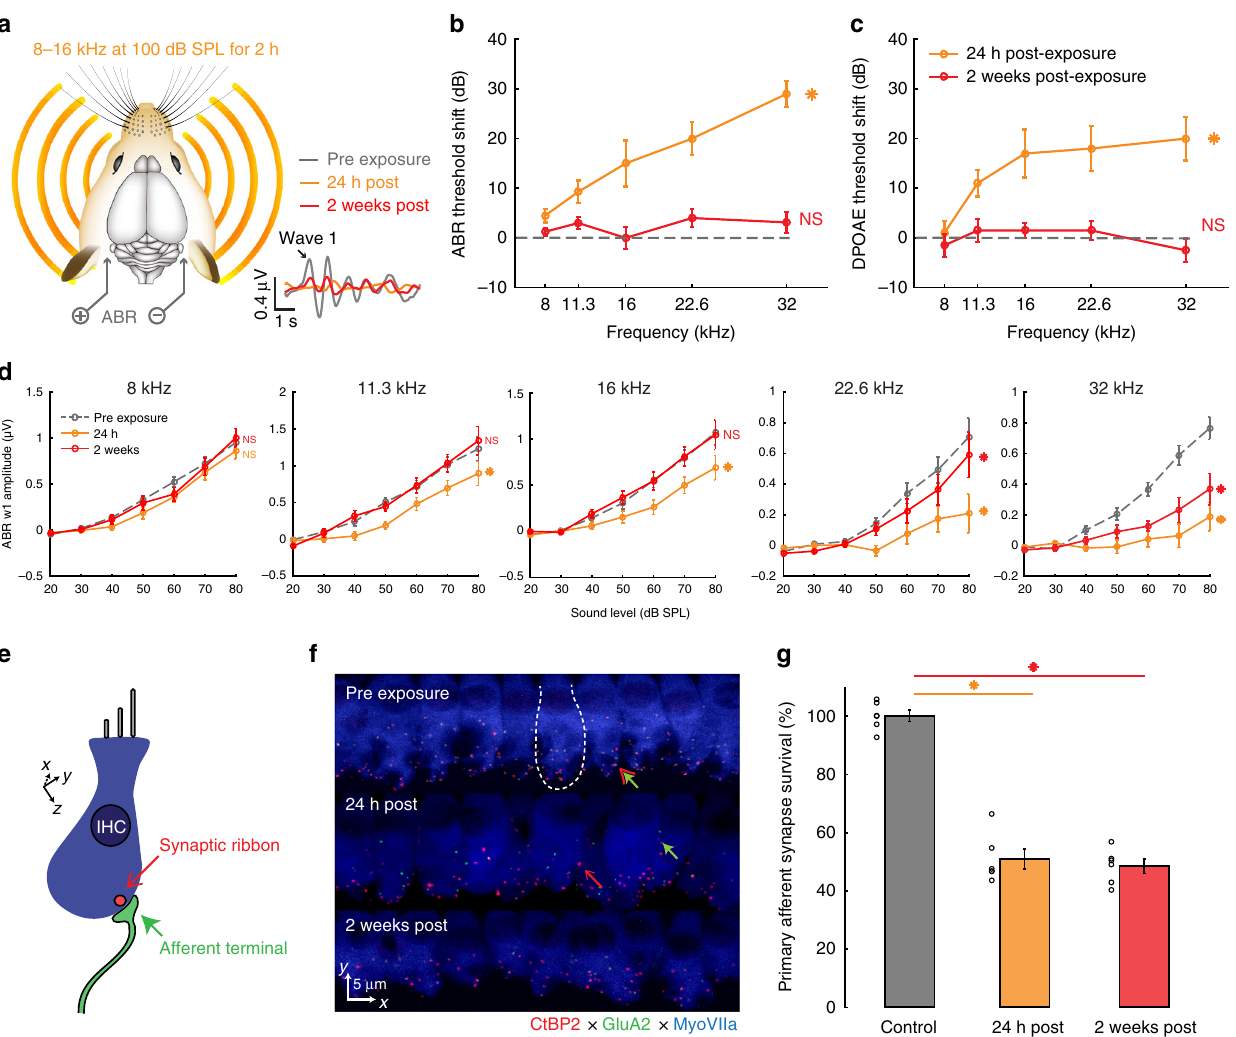
Fig. 3 Moderate intensity noise exposure induces a temporary shift in cochlear and brainstem response thresholds but a permanent loss of auditory nerve afferent fi bers. a Schematic of noise exposure and auditory brainstem response (ABR) measurement protocols. Example ABR waveforms evoked with a 32 kHz tone bursts before, 24 h after and 2 weeks after noise exposure. b , c Elevations in ABR and distortion product otoacoustic emission (DPOAE) thresholds ( b and c , respectively) are observed 1 day following noise exposure (orange) but have returned to baseline 2 weeks following noise exposure (red). d ABR wave 1 (w1) growth functions. NS indicates no signi fi cant difference with pre-exposure. Asterisk indicates signi fi cant main effect for ABR amplitude between pre-exposure and post-exposure. Data represent mean ± SEM, n = 10 mice in pre-exposure and 24 h post conditions, n = 8 mice for 2 weeks post. e , f Schematic ( e ) and actual ( f ) visualizations of cochlear nerve afferent synapses on inner hair cells. Red (open) and green (closed) arrowheads depict orphaned presynaptic ribbons and postsynaptic GluA2 receptor patches, respectively. Combined red (open) and green (closed) arrowhead identi fi es primary afferent cochlear synapses as appositions of the CtBP2 and GluA2 pre- and postsynaptic markers, respectively. Dashed white line depicts the boundary of a single inner hair cell. g Quanti fi cation of cochlear afferent synapses in control mice, 24 h and 2 weeks following noise exposure. Synaptic counts are expressed as percent survival by comparison to normative standards from age- and strain-matched mice 41,42 . Asterisk indicates signi fi cant difference with an unpaired t -test after correcting for multiple comparisons. Synaptic counts were made from 20.77 – 21.73 individual inner hair cells at a fi xed position in the cochlear frequency map between the 20 and 30 kHz region in each ear, 3 ears per group and 2 cochlear